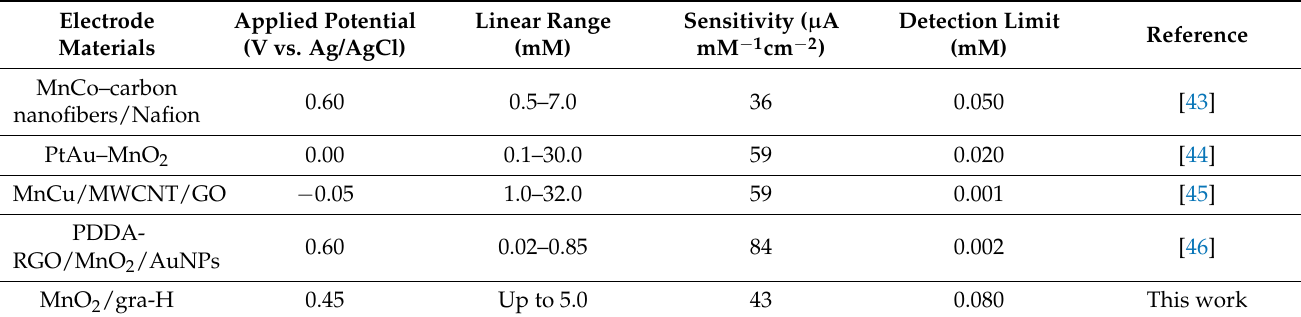
Table 5. Comparison of the non-enzymatic glucose sensing performance.